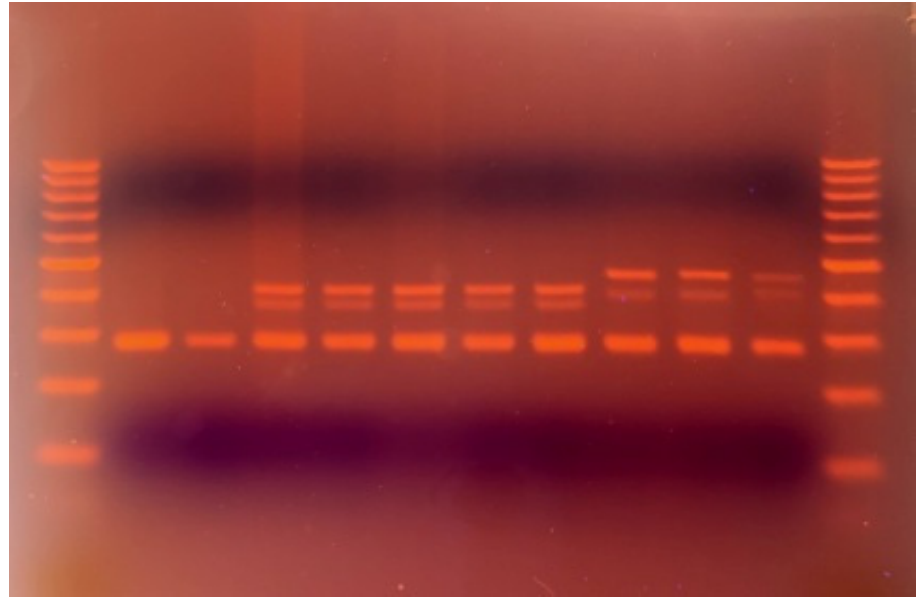
Figure 2. Image of 2% agarose gel electrophoresis of PCR-amplified fourth intron of Wknox1d DNA region of hexaploid wheat. Lanes: 2— T. turgidum subsp . carthlicum , 3— T. turgidum subsp. durum